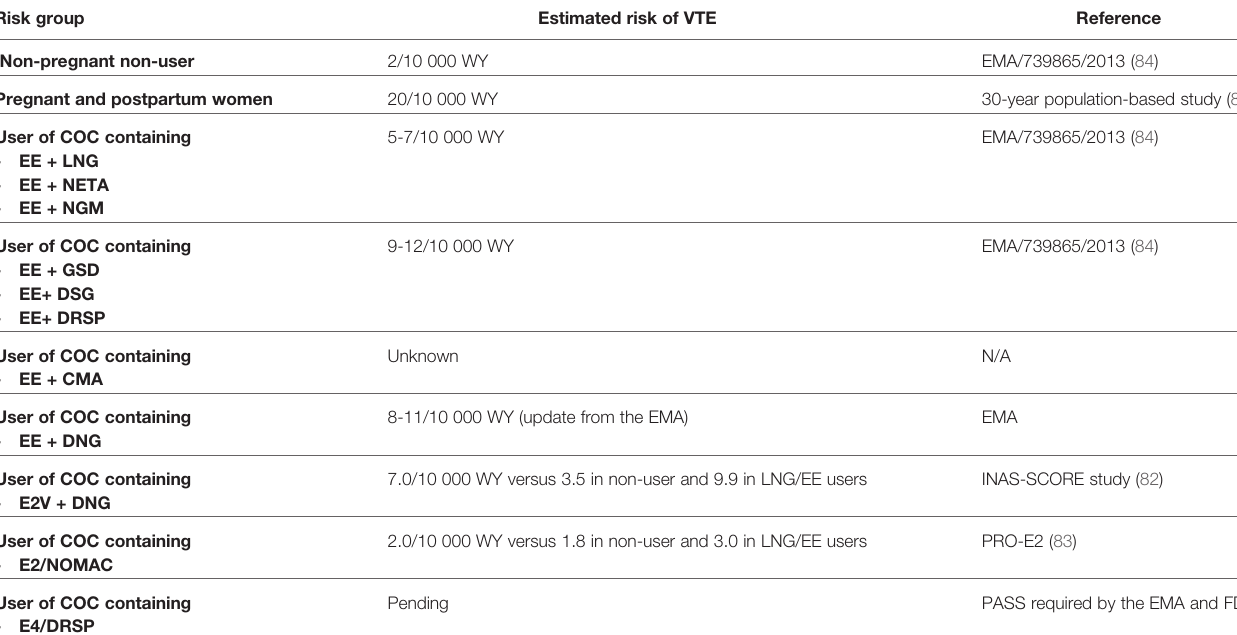
TABLE 3 | Estimated risk of venous thromboembolism events (VTE) with combined oral contraceptives